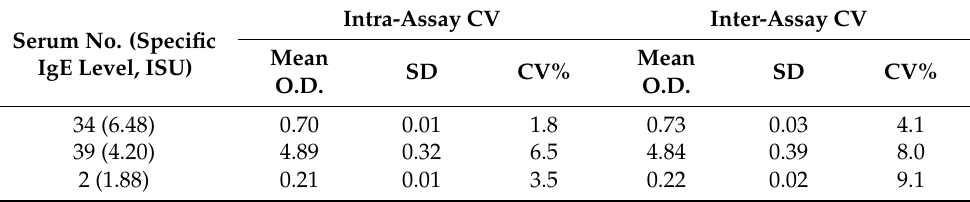
Table 4. Intra-assay and inter-assay coefficients of variation of ELISA based on rMus m 1.0102. Serum No. (Specific IgE Level,